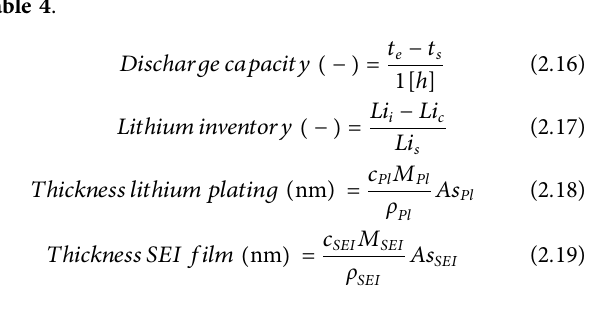
Simulation Design and Data Processing